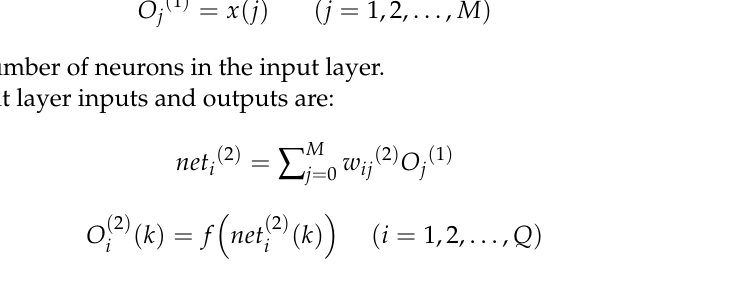
Figure 9. Optimization of PID parameters based on BP neural network.